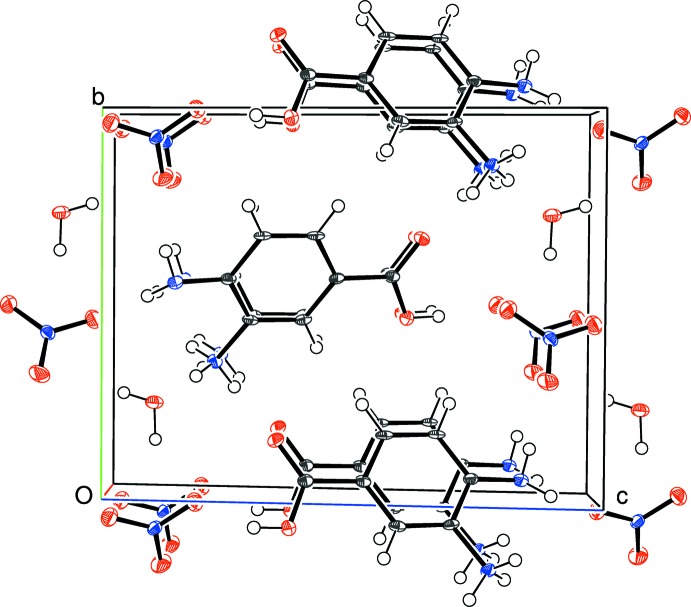
The packing for (III) viewed down [100].